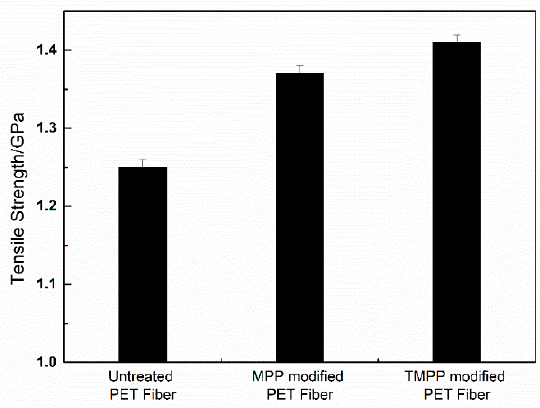
Figure 9. Tensile strength of single fiber.